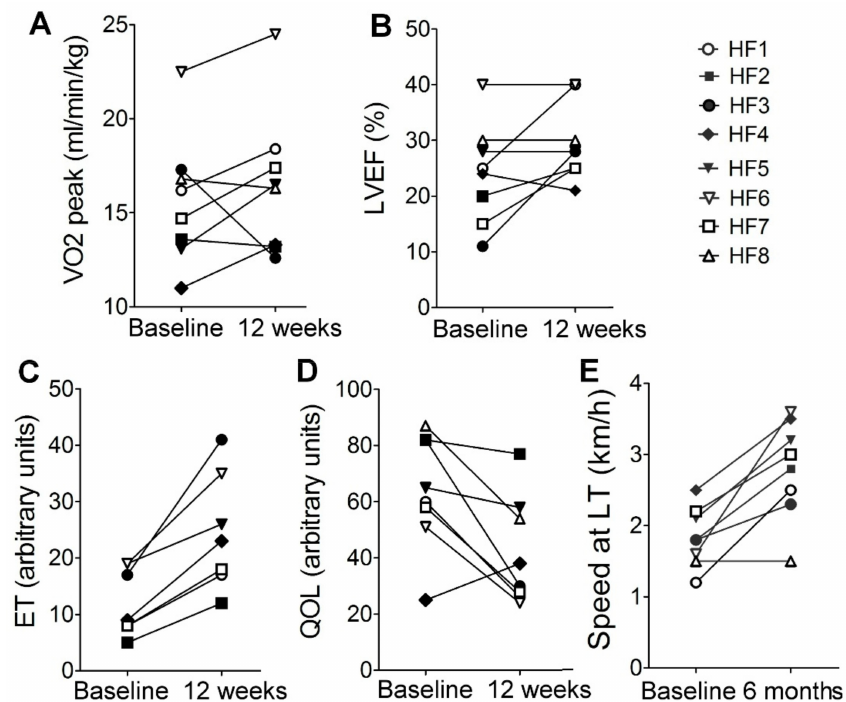
Figure 3. Physiological parameters of patients who provided skeletal muscle biopsy for histological and transcriptome analysis before and after exercise training program: ( A ) cardiorespiratory test (VO2 peak), ( B ) left ventricular ejection fraction (LVEF), ( C ) exercise tolerance (ET), ( D ) quality of life test (QOL), ( E ) speed at LT1. The increase in ET value indicates improvement in exercise tolerance; the decrease in QOL value indicates the improvement in the quality of life test results. Patient HF8 did not show up for the ET